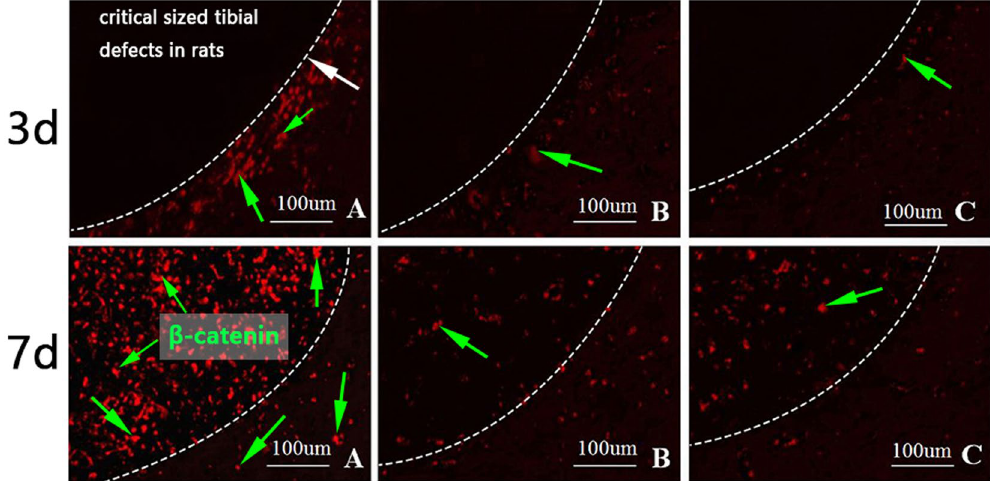
Figure 9. Immunofluorescence staining for β -catenin (green arrow). The white arrow indicated the bone defect edge. In group A, punctate red fluorescence was detected near the bone defect edges on day 3 and it was observed in bone defect areas on day 7. The fluorescence intensity and density of group A were obviously stronger than the other two